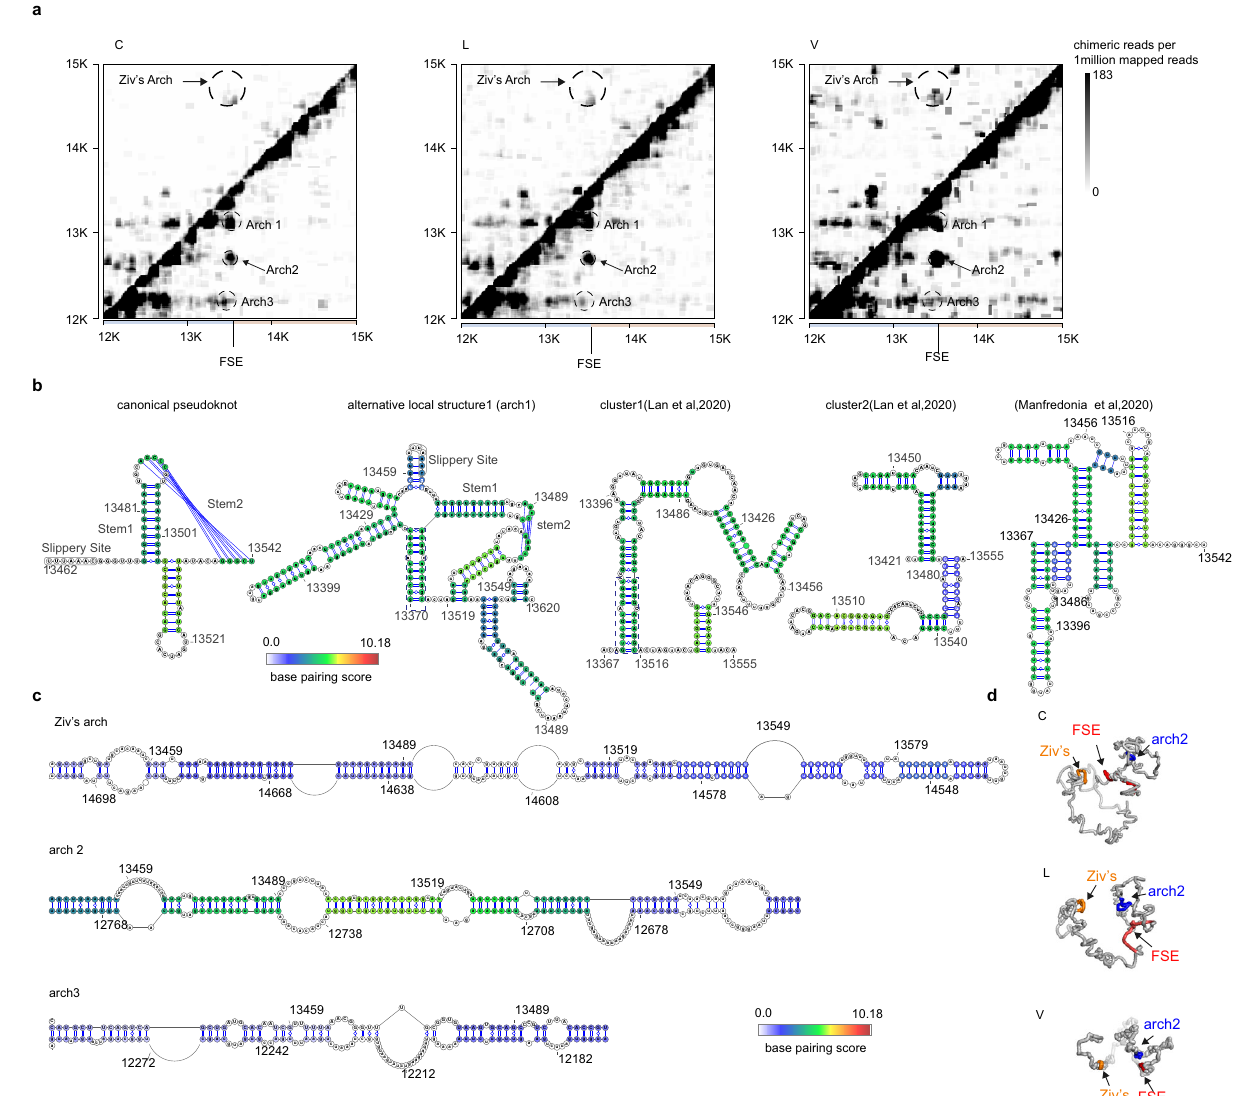
Fig. 3 Alternative local and long-distance FSE structures. a Heatmaps show chimeric reads spanning 12 K – 15 K of SARS-CoV-2 genome in individual samples. Ziv ’ s arch and alternative arches were plotted as indicated. b Base pairing of canonical pseudoknot and alternative structures as indicated, overlaid by base-pairing scores in C samples. c Base pairing of indicated arches. Colors represent the base-pairing score counts of non-redundant chimeric reads supporting each base pair. d 3D modeling of structure around FSE. FSE is in red, whereas nt14548 – nt14708 (arch4 partner) is orange and nt12702 – nt12802 is